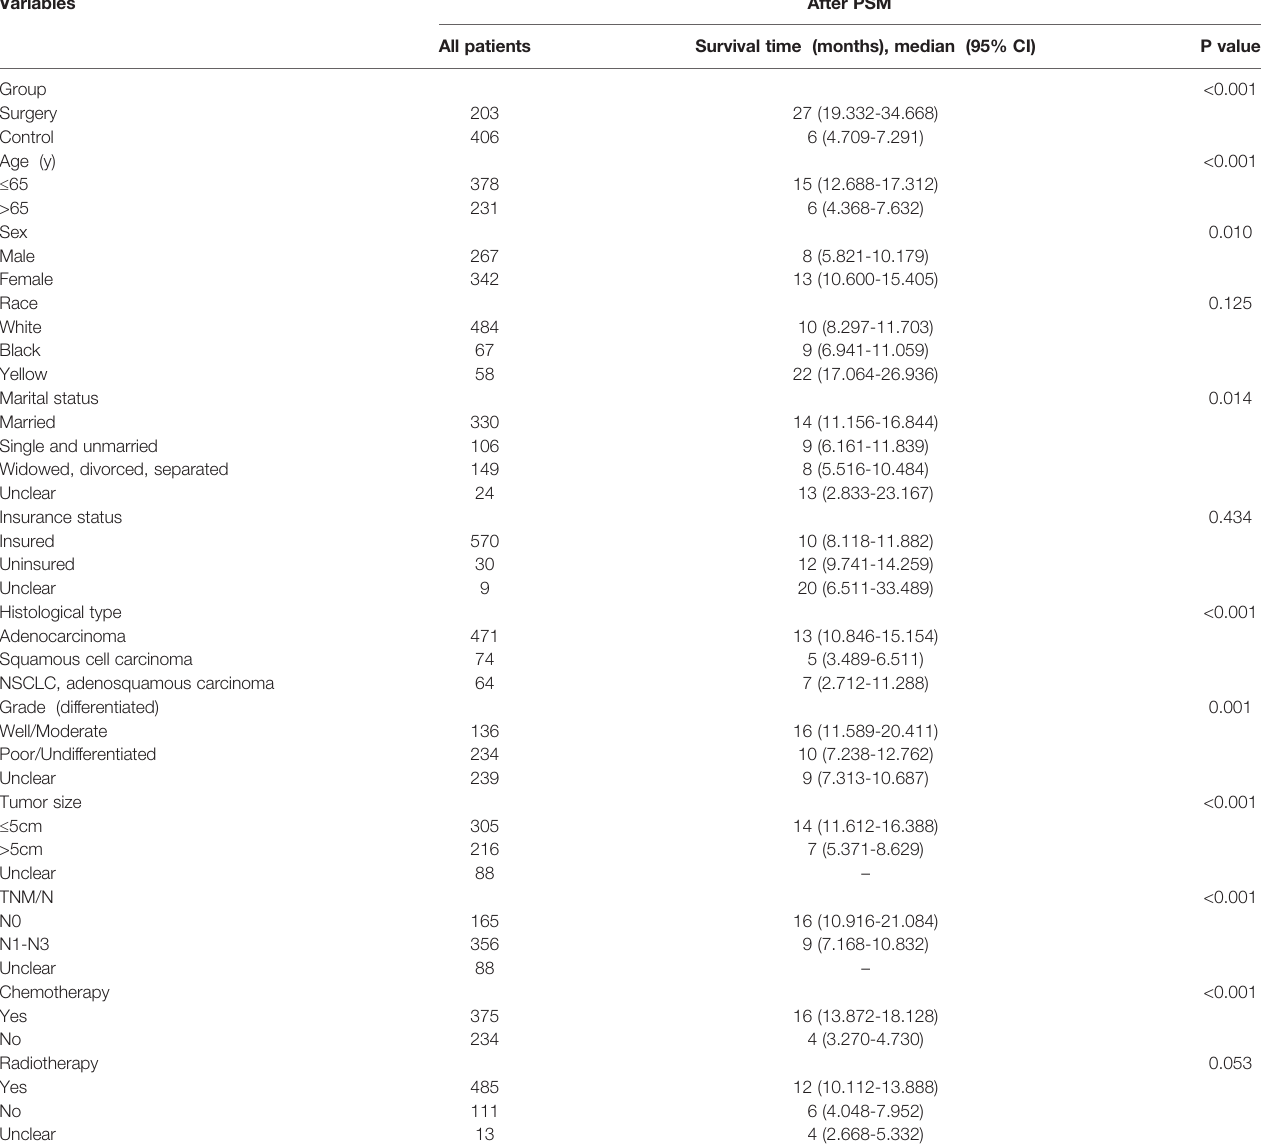
TABLE 2 | Univariate analysis of prognostic factors for OS. Variables After